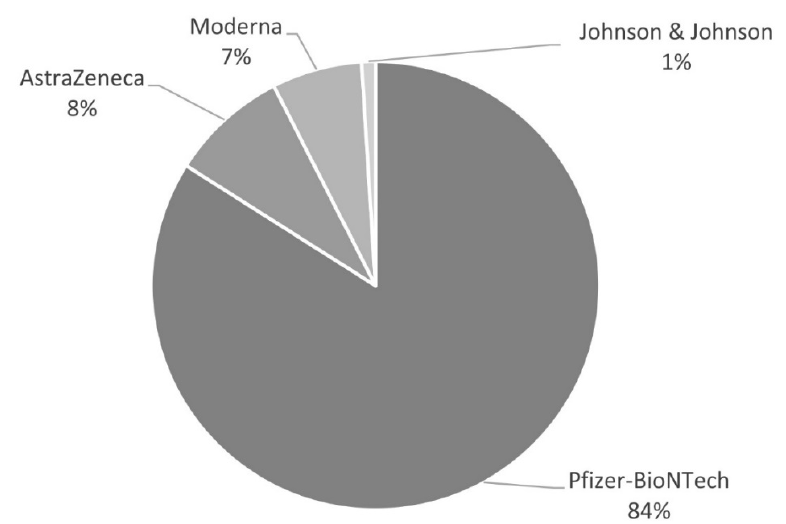
Figure 2. Types of COVID-19 vaccines received by vaccinated PAH/CTEPH patients. Seventy-seven percent of vaccinated patients reported at least one post-vaccination adverse event (AE). The majority of AEs were mild or moderate and disappeared in a few days. The most frequently reported side effects were site injection pain (54.5%), fever (22%), fatigue (21%), myalgia (10.5%), headache (10%), and chills (6%). Serious adverse events (SAE) were reported by 5 patients. One patient with CTEPH was diagnosed with acute glaucoma on the third day after receiving the first dose of the AstraZeneca vaccine, which led to his refusal to take the second dose of the vaccine. One CTEPH patient, who had a rapid progression of bladder cancer with distal metastasis, had prolonged hypotension after receiving the second dose of the Pfizer-BioNTech vaccine, and thus needed to reduce his use of riociguat. One patient with a permanent cannula in their right subclavian vein and superior vena cava for continuous infusion of epoprostenol had venous thrombosis in their right internal jugular vein at the bend of the Hickman’s catheter. This episode was asymptomatic and detected accidentally on the seventh day after the second dose of the Pfizer-BioNTech vaccine had been administered, when the patient had their routine right heart catheterization to check if the treatment of the PAH disease was sufficient. This patient was taking apixaban due to their previous history of acute pulmonary embolism. One patient with CTEPH had acute bronchitis on the third day after receiving the second dose of the Pfizer-BioNTech vaccine, leading to their hospitalization. One patient with PAH had paroxysmal atrial fibrillation on the fifth day after receiving the first dose of the Pfizer-BioNTech, and electrical cardioversion was needed; there was no arrythmia after the second dose. One SAE was classified as probably related to the given COVID-19 vaccine and 4 SAEs as possibly related to the given vaccines. All reported adverse events in PAH/CTEPH patients are presented in Figure